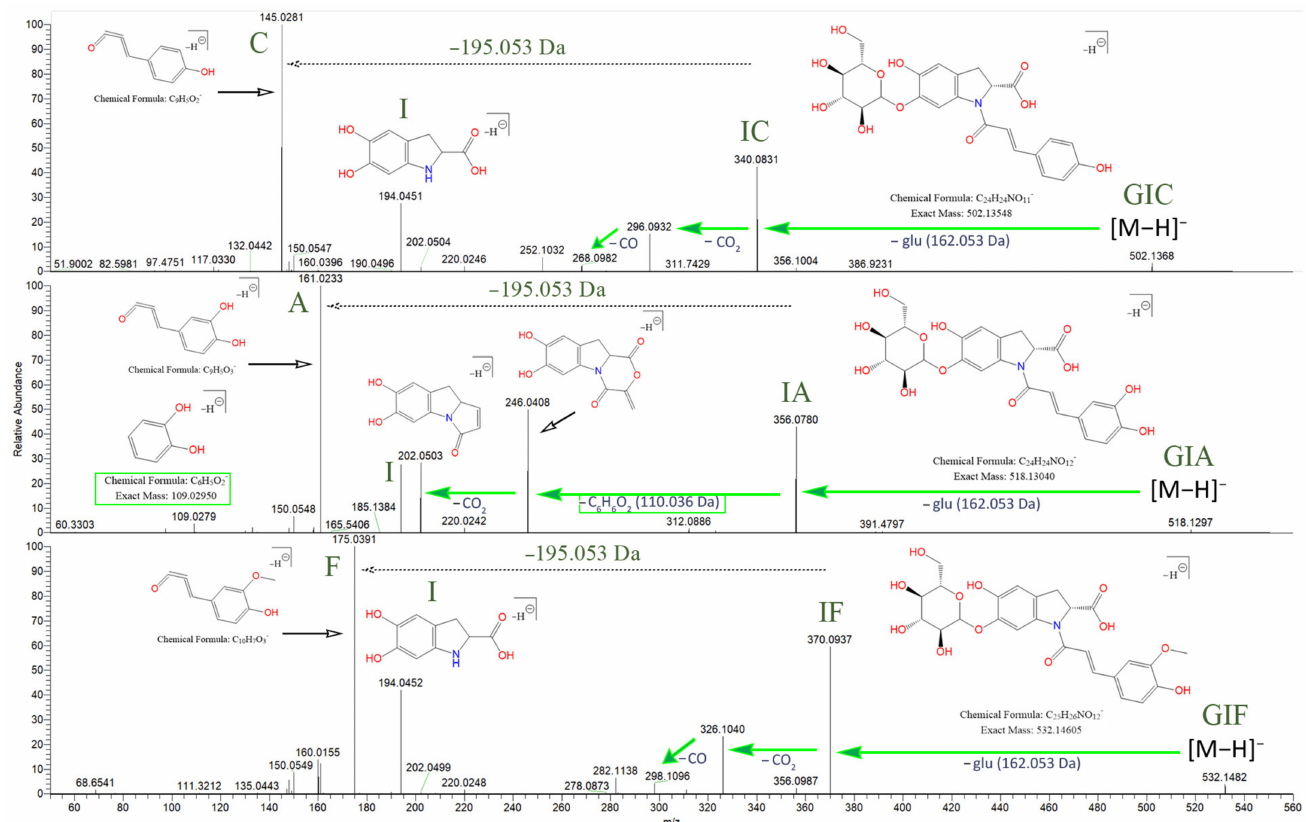
Figure 4. Fragmentation behavior for GIC, GIA, and GIF with proposed chemical structures. The searched specific difference of 195.05316 Da is marked, suggesting a neutral loss of 5,6-dihydroxyindoline-2-carboxylic acid (the indoline core). As shown, IA demonstrates a different fragmentation behavior, compared to IC and